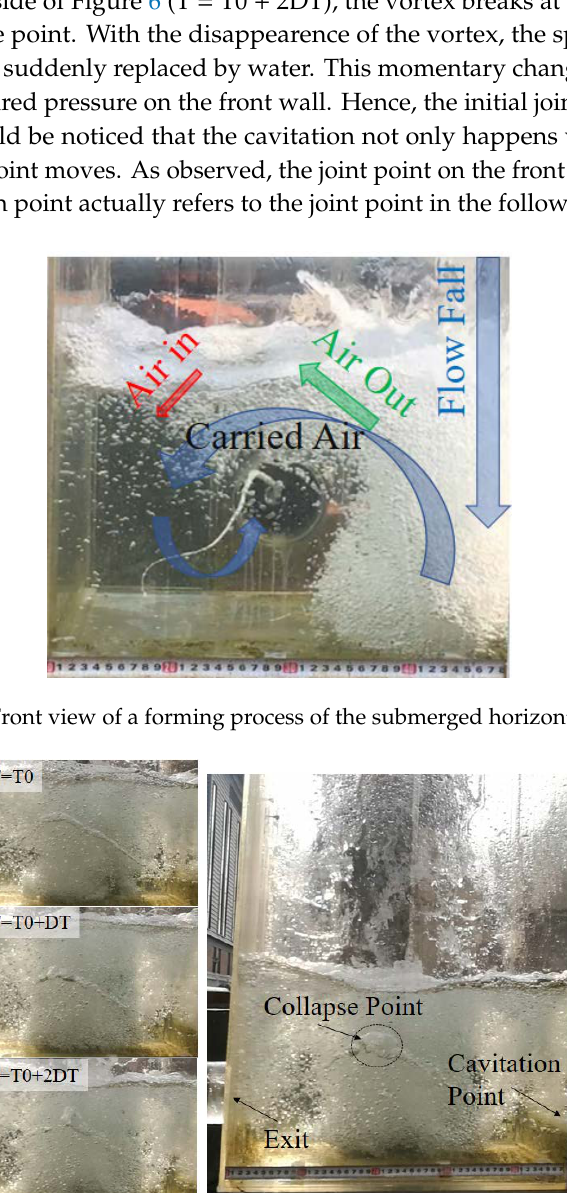
Figure 6. Side view of a collapse process of the submerged horizontal vortex.